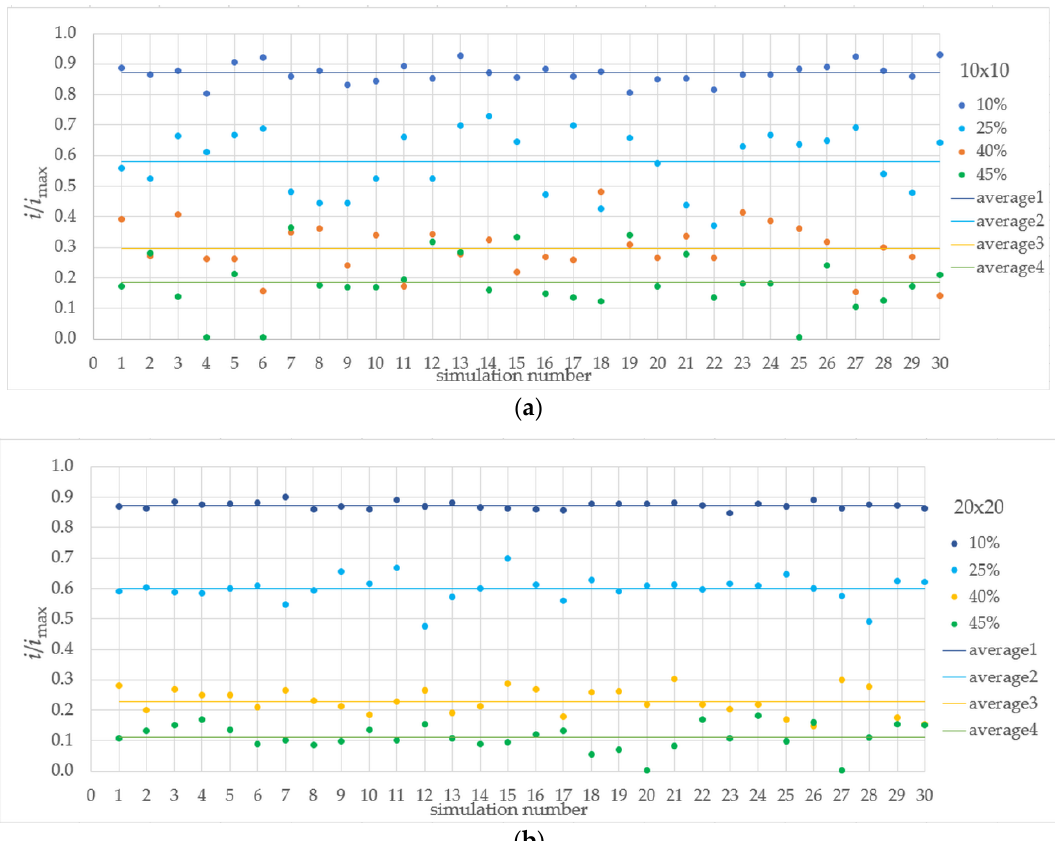
Figure 6. Results of current calculations for models with mesh dimensions 10 × 10 ( a ) and 20 × 20 ( b ) and different defect concentrations: p = 10%, 25%, 40%, 45%. Points marked with the same color for a given mesh correspond to different draws of defects with the same model parameters.